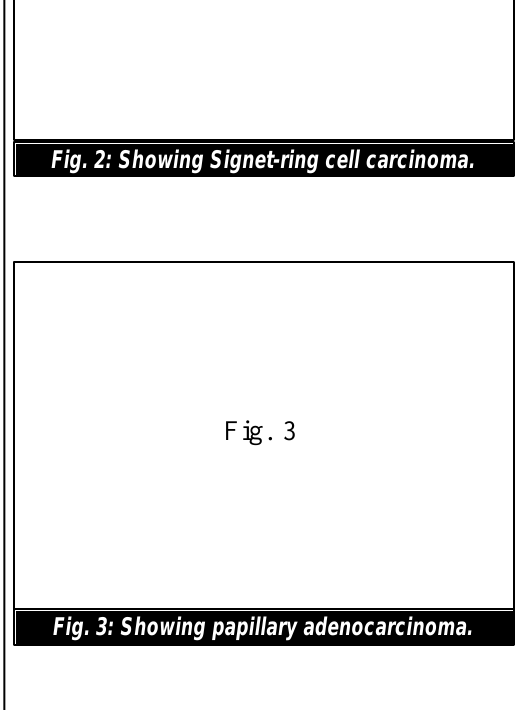
Fig. 4: Showing mucinous adenocarcinoma.